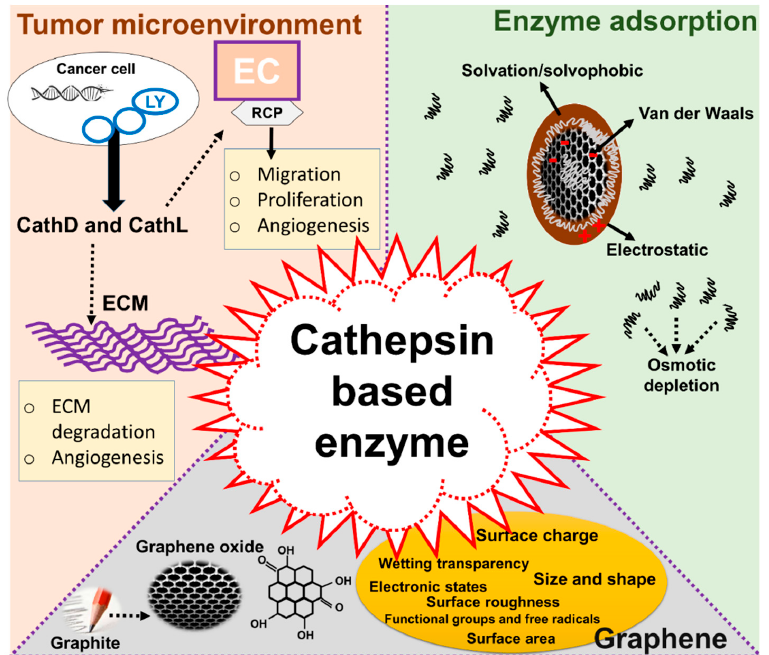
Figure 1. Proposed mechanism of cathepsin function in cancer metastasis and use of graphene oxide (GO) as an adsorbent to remove cathepsin from a living system. There are three panels in this diagram: (1) role of cathepsins in cancer progression: (2) structure of GO and its parameters relevant to the adsorption of cathepsins: and (3) the mechanism of adsorption. The left panel (1) illustrates possible tumorigenic and proangiogenic roles of cathepsin D (CathD) and cathepsin L (CathL) within the cancerous stroma or extracellular matrix (ECM) on endothelial cells (EC) acting via an unknown receptor(s) (RCP). The bottom panel (2) shows the structure of GO. This is prepared from graphite